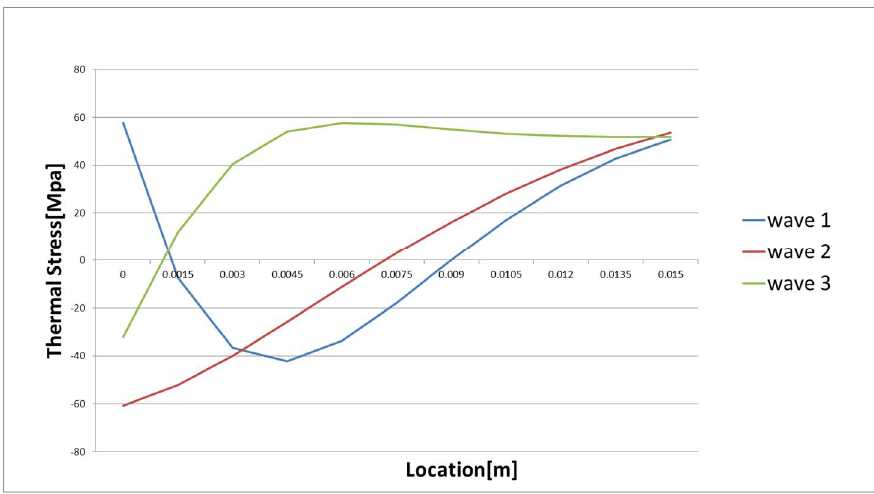
Figure 3. Thermal stress distribution at t = 5